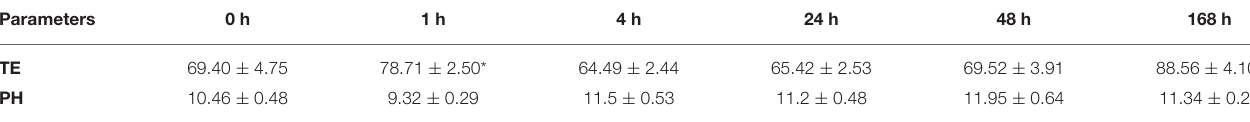
TABLE 2 | Means ± SEM of the pixel number and its standard deviation (testicular echogenicity and pixel heterogeneity) of the testicular parenchyma ultrasound B-mode images as analyzed using Photoshop program at the studied time points: just before LC treatment (0h) and 1, 4, 24, 48 and 168h post-treatment in Ossimi rams ( n = 15). Parameters